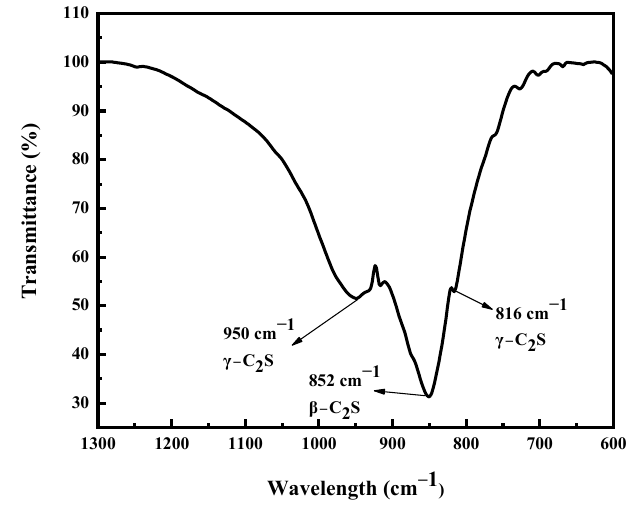
Figure 2. FTIR pattern of AOD slag. Table 3. Carbonation reaction equations and their ∆ rG θ of minerals in AOD slag. Mineral Phase Carbonation Reaction